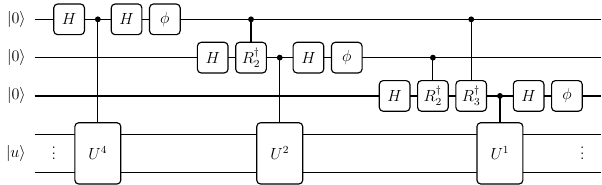
FIG. 15. An illustration of three-qubit quantum phase estima- tion using QSP, in the simplified case when d = 1.